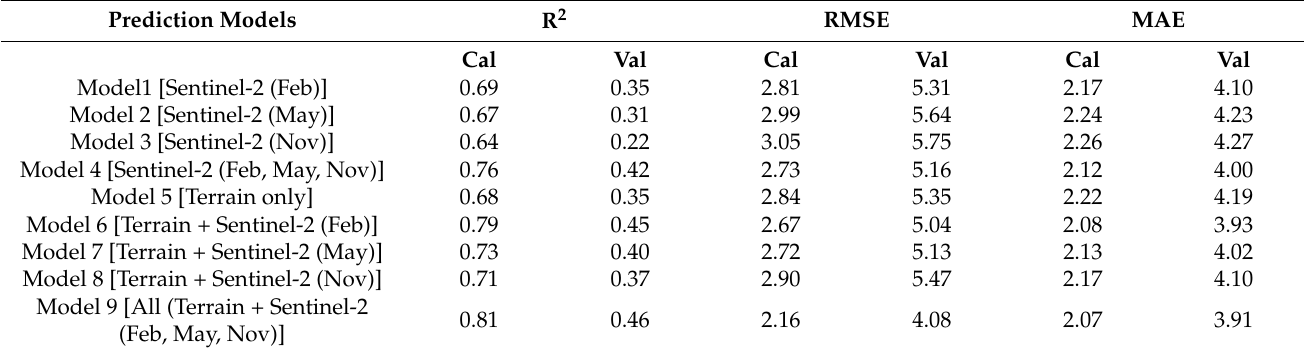
Table 4. Goodness of fit and error statistics of predictive models.